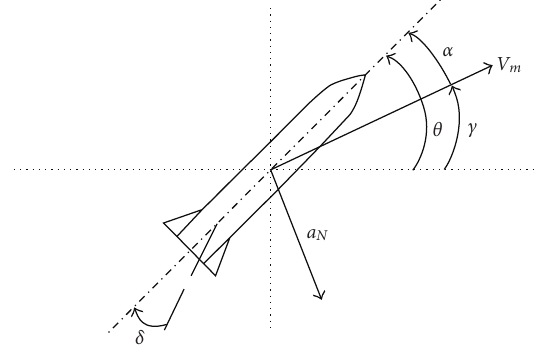
Figure 1: Airframe and dynamic